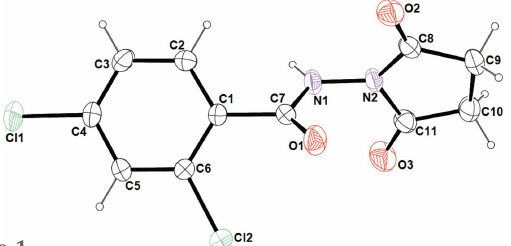
Figure 1 The molecular structure of the title compound with the atom-labeling scheme. Displacement ellipsoids are drawn at the 40% probability level. H atoms are shown as small spheres of arbitrary radii.